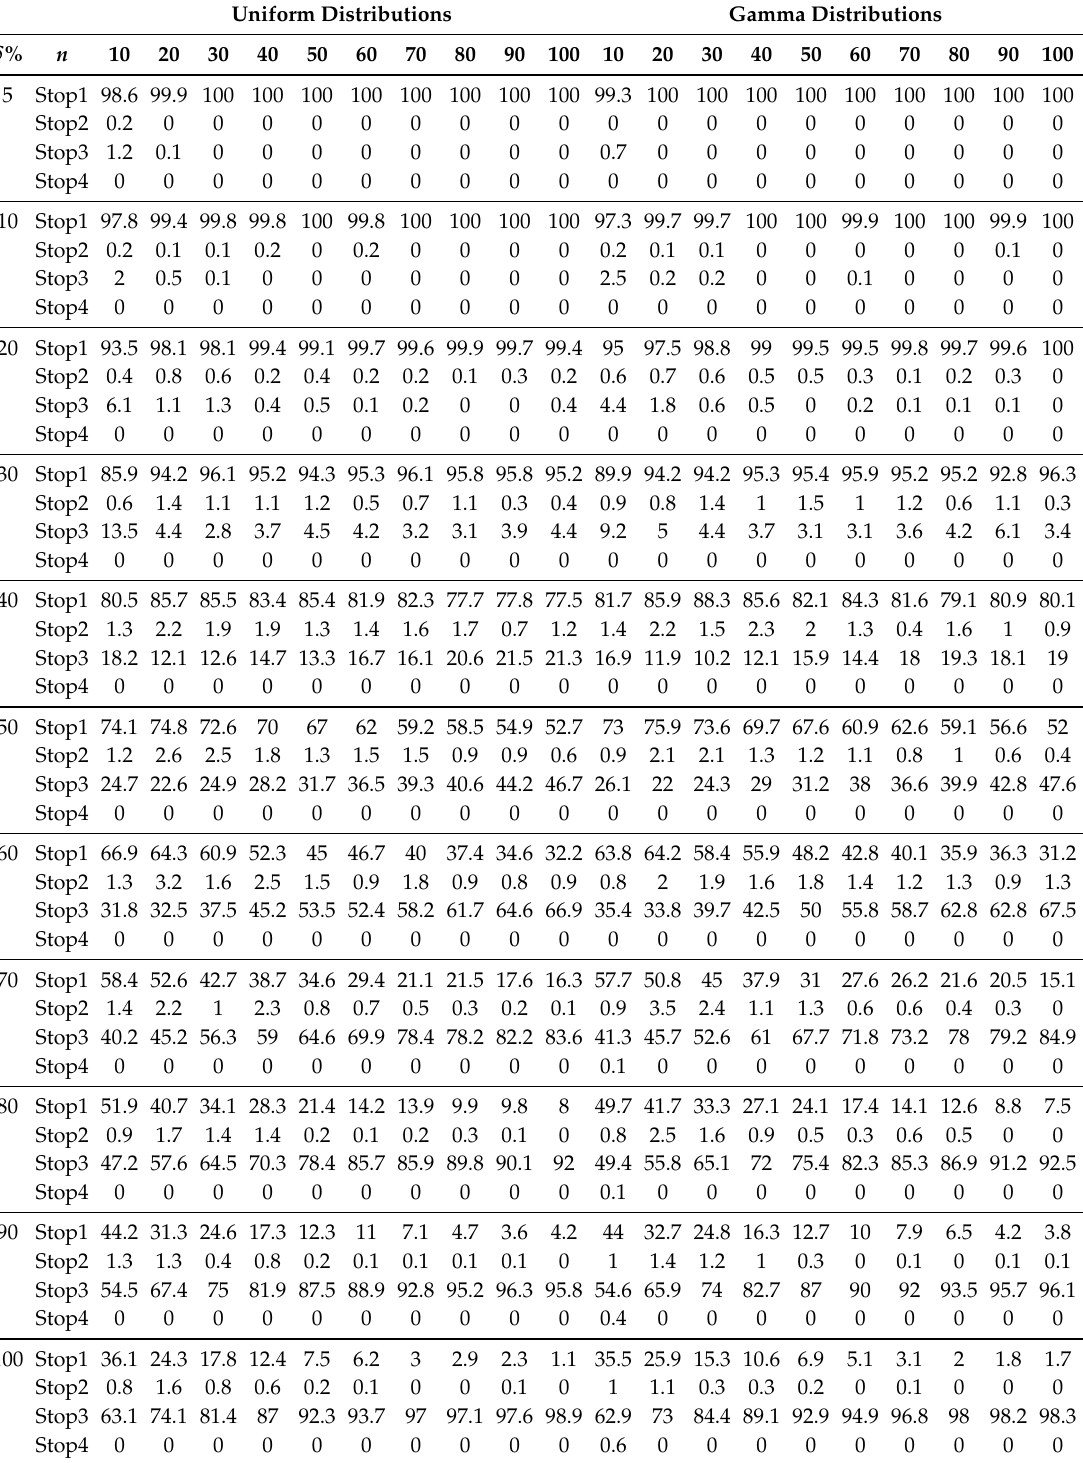
Table A12. Computational results for randomly generated instances with the ratio 10%:30%:10%:50% of the numbers of jobs in the subsets J 1 , J 2 , J 1,2 and J 2,1 of the job set J . Uniform Distributions Gamma Distributions